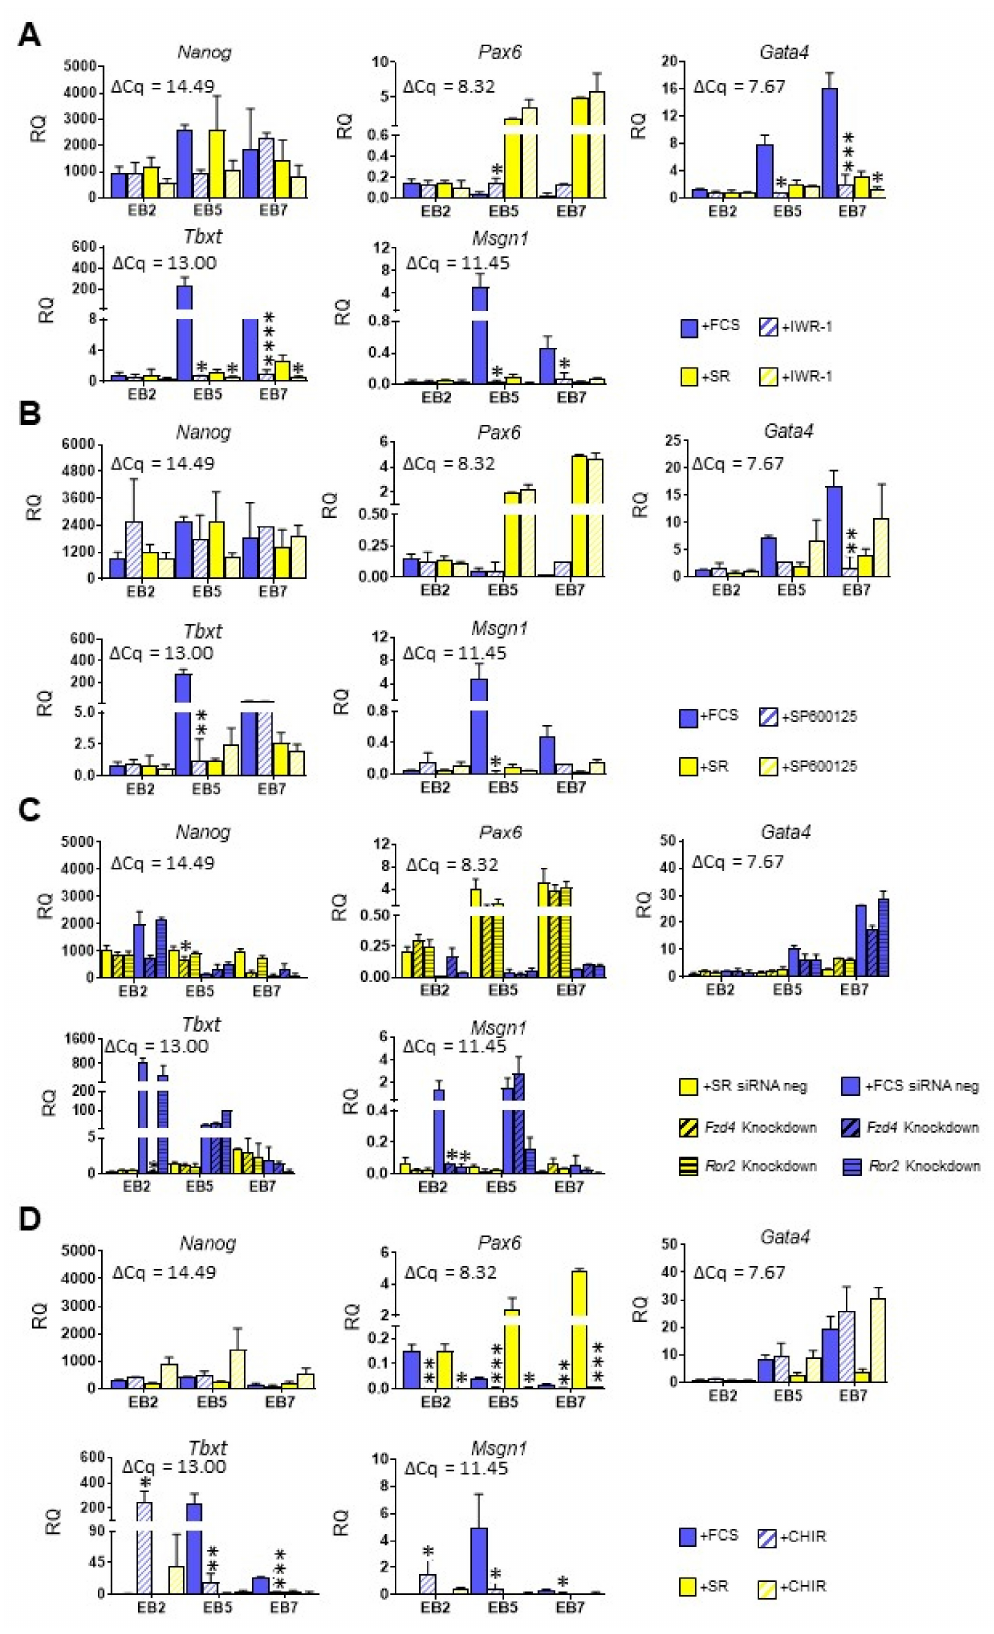
Figure 6. Analysis of ESC differentiation in medium supplemented either with FCS or SR after modification of either canon- ical or noncanonical WNT pathway. ( A ) Expression of germ layer markers in control or IWR-1-treated EBs. ( B )